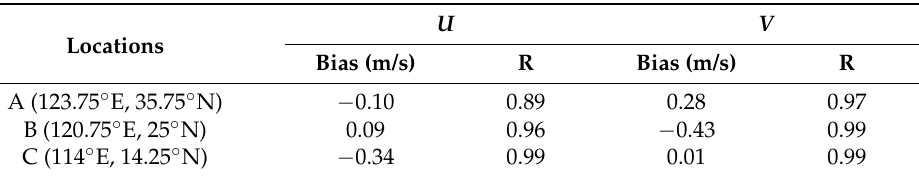
Figure 4. Comparison of QuikSCAT and ASCAT observed zonal ( U ) and meridional ( V ) wind speed time series at three grid points (shown in Figure 1) during the overlapping observation period from January 2007 to November 2009. Table 1. The correlation coefficient (R) and mean bias between QuikSCAT and ASCAT wind speed time series at three grid points.